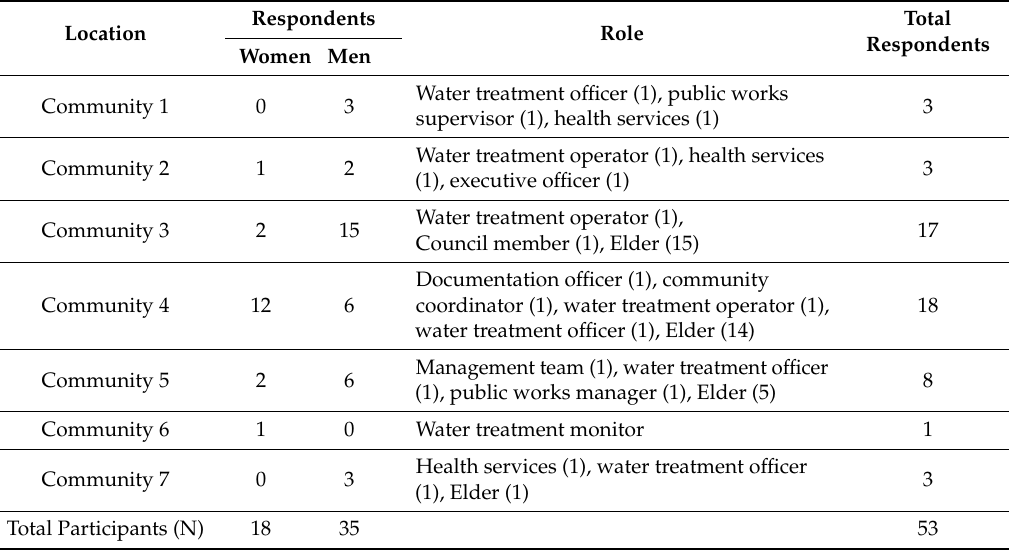
Table 1. Genders and roles of